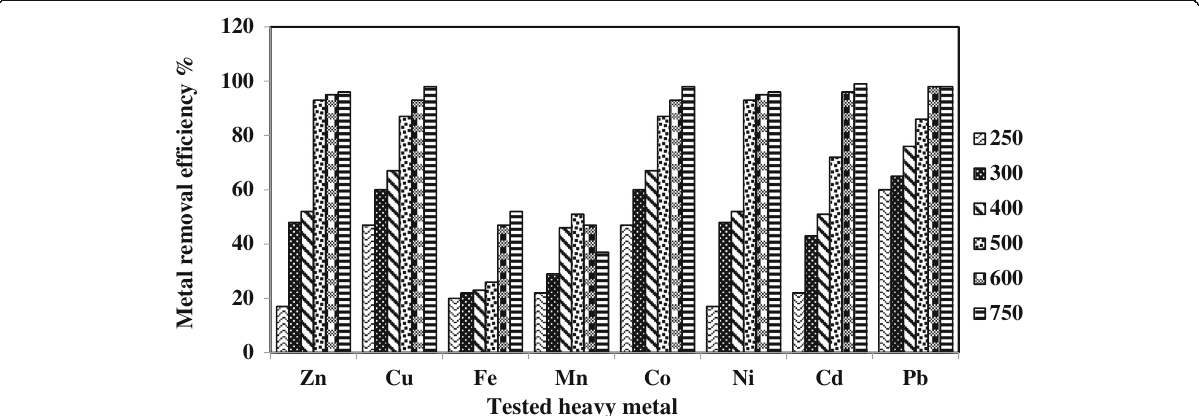
Fig. 5. A histogram showing the effect of using different P. aeruginosa biomasses (250 – 300, 400, 500, 600, and 750 mg/l) at pH 7.5 on metal removal efficiency %